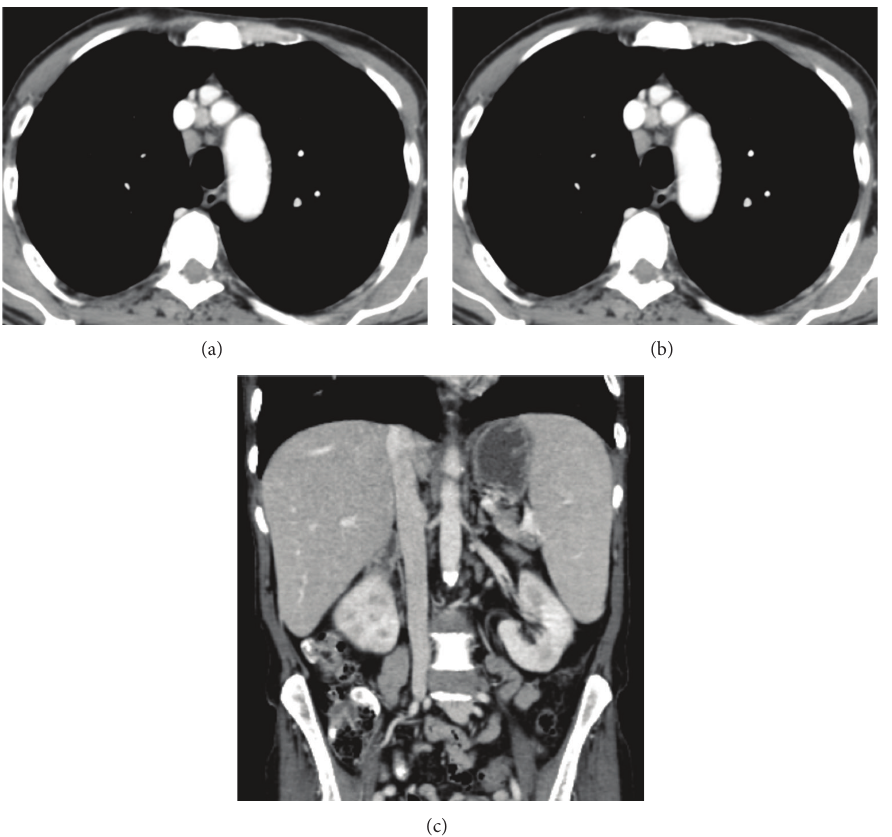
Figure 1: Axial postcontrast CT of the chest ((a) and (b)) shows minimally enlarged mediastinal lymph nodes; the largest one in the right pretracheal region measures about 12.3 × 11.1mm. Coronal postcontrast CT of the abdomen (c) shows mildly enlarged spleen and liver measuring about 14.5 and 15.7 cm, respectively, without evidence of focal lesions or associated abdominal